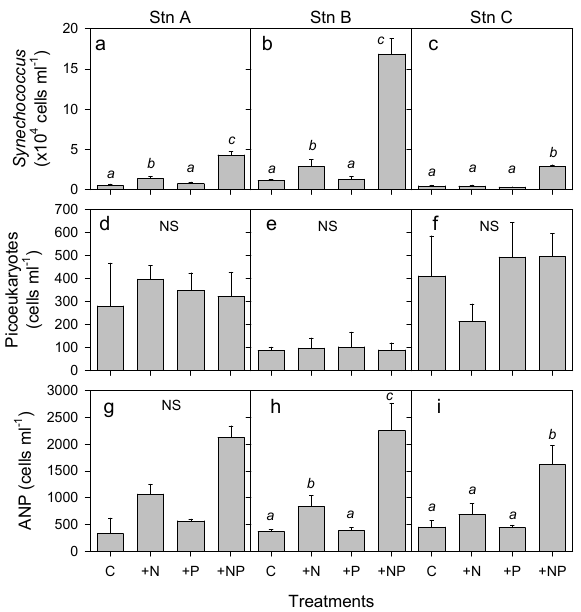
Fig. 5. Comparison of responses of abundance (cellsml − 1 ) of Synechococcus ( a, b, c ), picoeukaryotes ( d, e, f ), and autotrophic nanoplankton (ANP) ( g, h, i ) between the different treatments at the last day of the experiment. Values are shown as mean ± SD. C, +N, +P, and +NP denote Control, NH 4 addition, PO 4 addition, NH 4 +PO 4 addition, respectively. Columns labeled by different italic letters ( a , b or c) are significantly different at P < 0 . 05. NS denotes no significant effect of different nutrient treatments on the parameter measured. See Materials and methods for details.